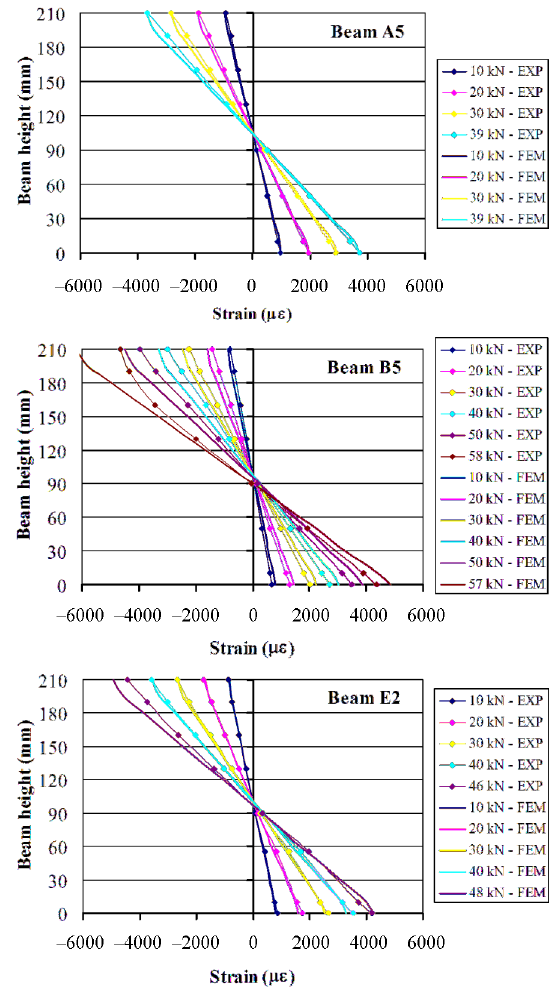
Fig. 8. Strain profiles at different load levels for unreinforced (Series A) and reinforced (Series B and Series E) beams: comparison between experimental tests and numerical modelling